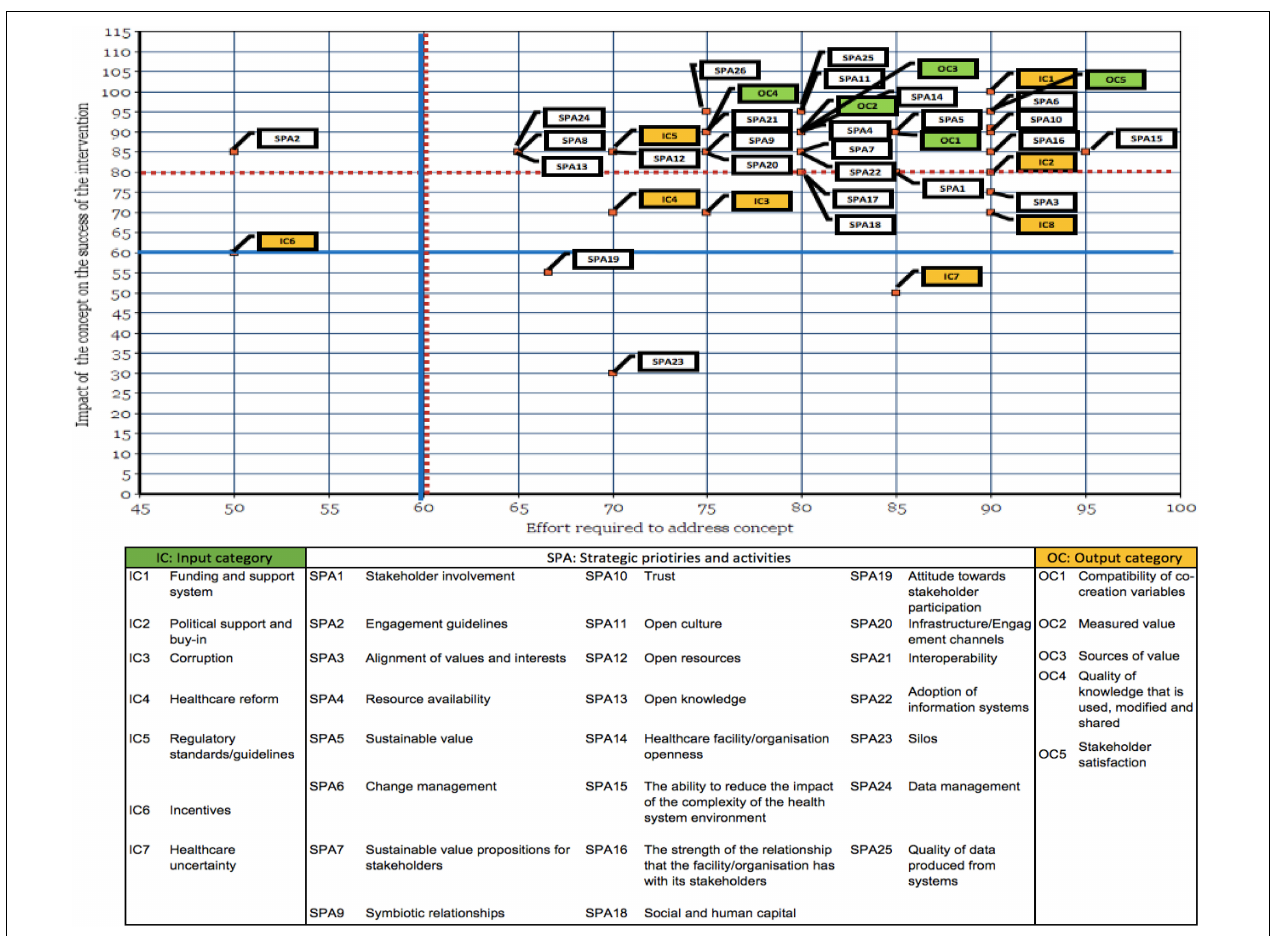
FIGURE 8 | Comparison of the respective degrees of impact and effort for each concept Discussion (Part